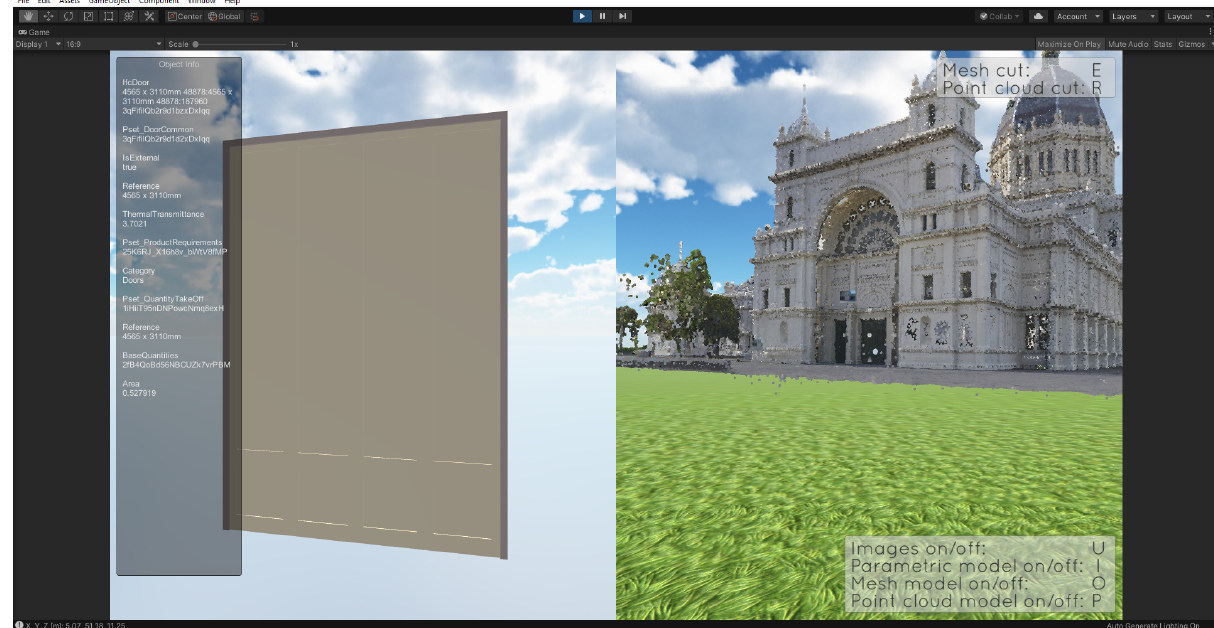
Figure 2. Split screen after the inspection of a building element, showcasing the integration of the front and the back layers in the platform. Information from the IFC file is listed on the left, while movement and inspection remains functional on the